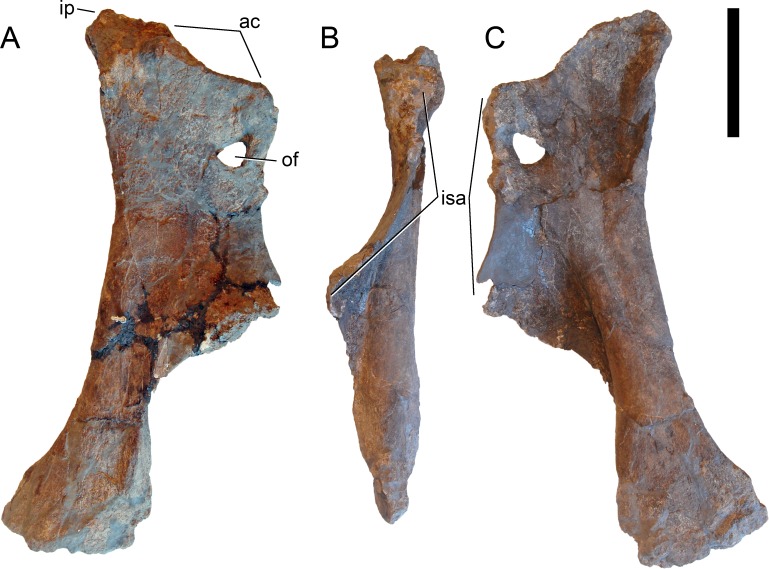
Right pubis of Galeamopus pabsti SMA 0011.The pubis is shown in medial (A), posterior (B), and lateral (C) view. Abb.: ac, acetabular surface; ip, iliac peduncle; isa, ischial articular surface; of, obturator foramen. Scale bar = 20 cm.